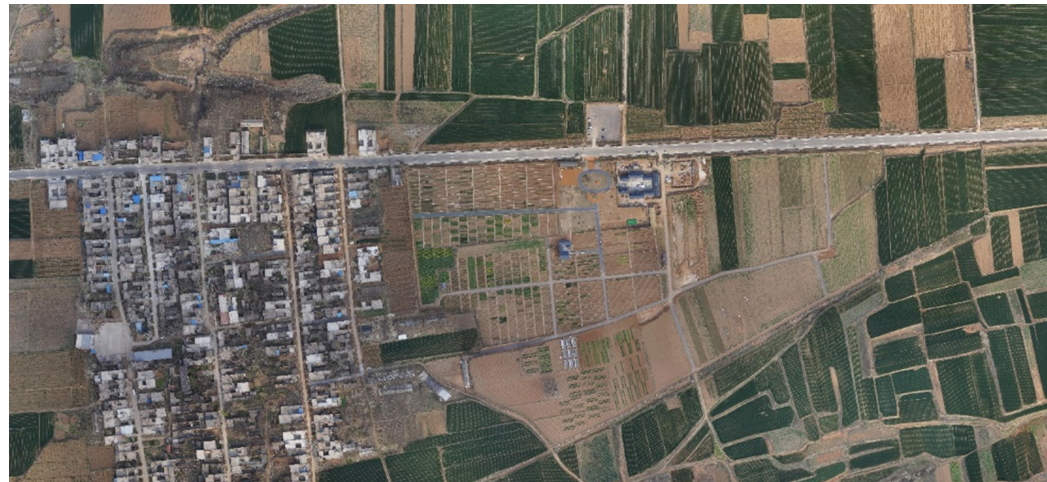
Figure 2. Mosaic Unmanned Aerial Vehicle images (Luoyang Region).